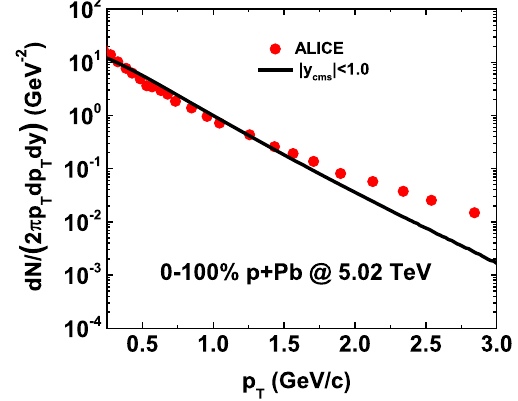
Fig. 3 Charged hadron spectra at midrapidity in center of mass frame in minimum-bias 5.02 TeV p + Pb collisions, compared to data from the ALICE Collaboration [47]